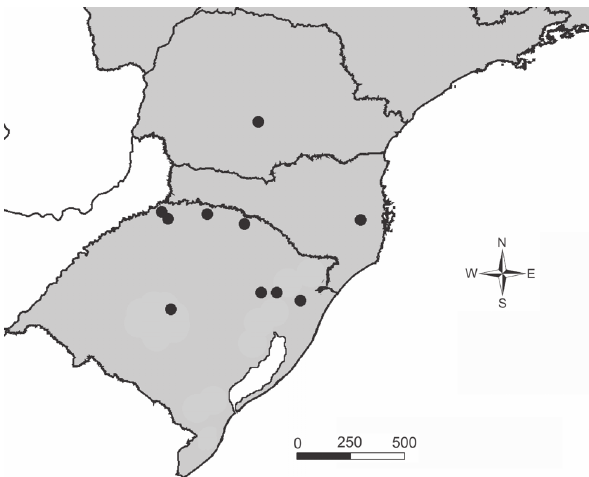
Figure 17. Map of southern Brazil showing the distribution of Dubiaranea argenteovittata